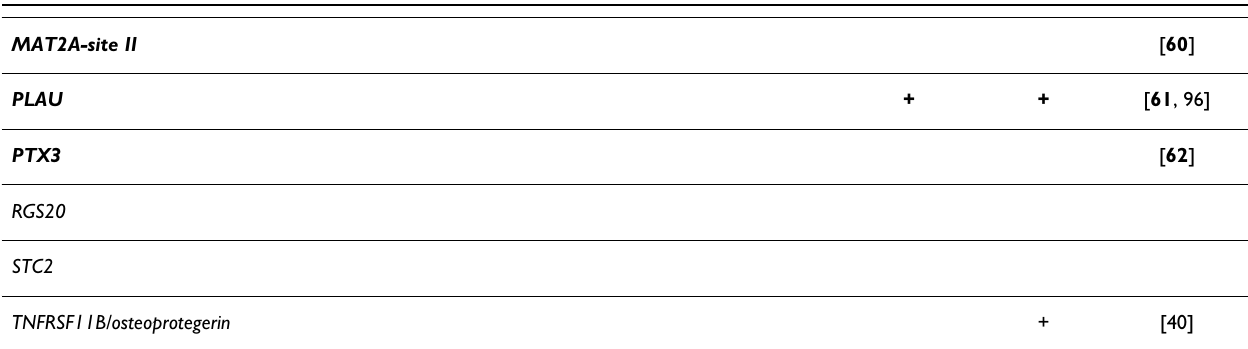
All PI 3-kinase regulated genes containing upstream binding sites for either FOXO or NF  B are listed. Genes containing a previously reported FOXO or NF  B binding site, and the relevant reference, are in bold. The biological activity of each gene, as it pertains to growth factor/receptor or cytokine, transcription, proliferation, and apoptosis, is indicated along with references for these activities.